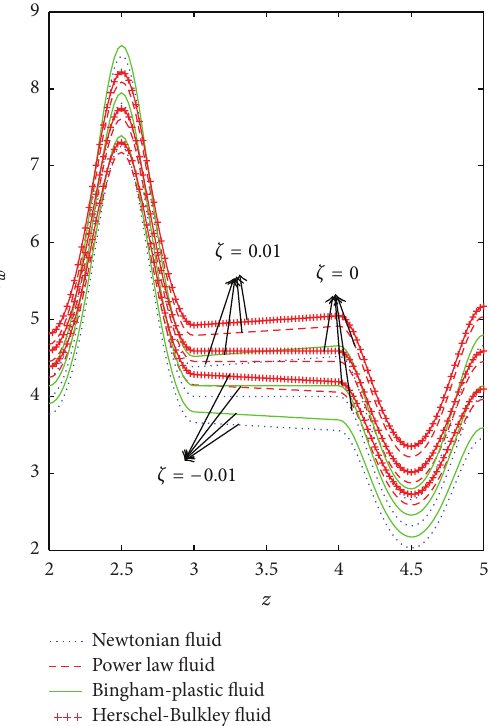
Figure 4: Axial variation of wall shear stress for Newtonian, power law, Bingham-plastic, and Herschel-Bulkley fluids with different values of 𝜁 .